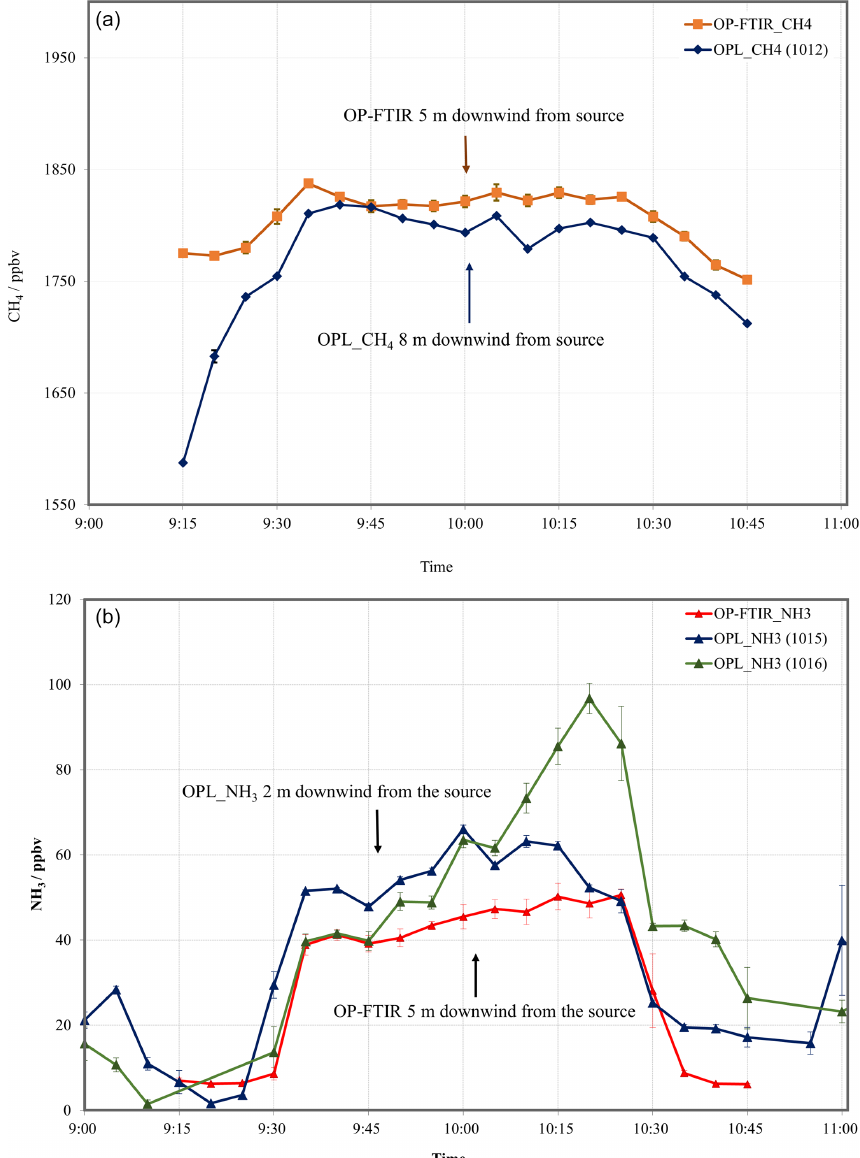
Figure 7. The 5min averages of CH 4 (a) and NH 3 (b) mole fraction measurements from the OP-FTIR and OPL downwind of a ground-level grid source 40 × 15m wide (path length = 125m) at Kyabram on 3 August 2005 (T2). The error bars represent the standard